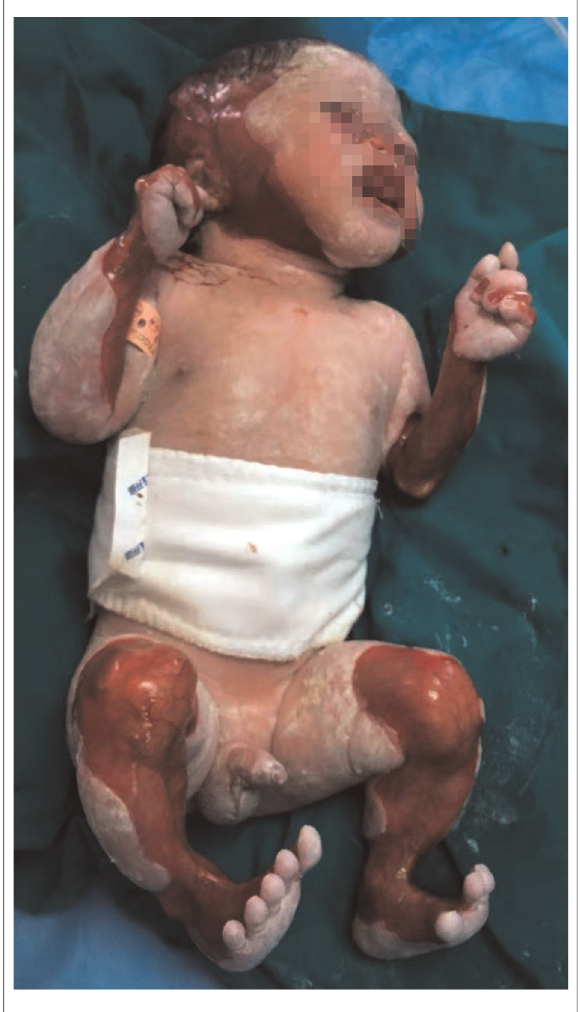
FIGURE 1 The fi rst child of this mother with aplasia cutis